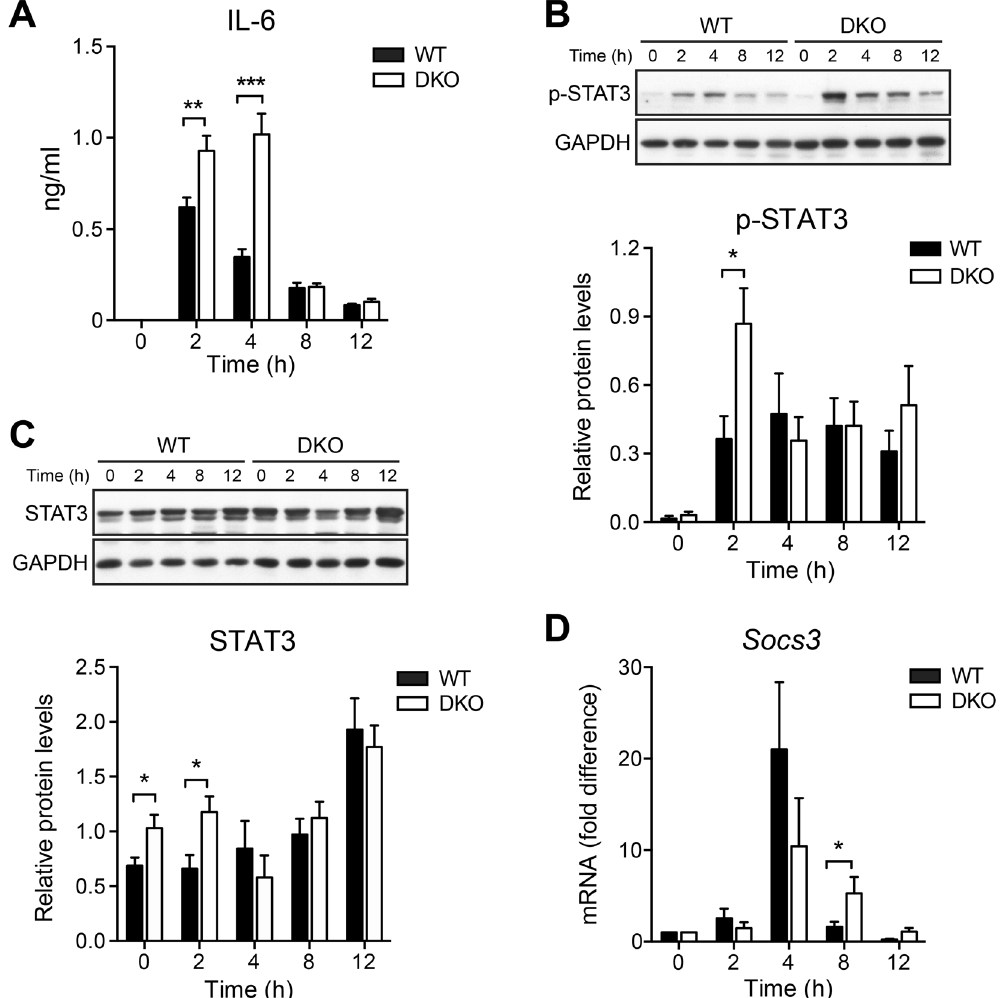
Figure 2. The IL-6 pathway and early STAT3 signalling are enhanced in the absence of cytosolic nucleic acid sensing. (A) Systemic levels of IL-6 were measured using serum samples from 4 to 7 independent mice for each time point and group. (B) Hepatic levels of phosphorylated STAT3 were determined by Western blotting. Representative gels (upper panel) and densitometric analyses (lower panel) are depicted. For each time point and in each group, samples from 6 independent mice were analysed. Cropped gels are shown. Full length gels are available in the supplemental information. (C) Expression of total STAT3 protein was determined by Western blotting. Representative gels (upper panel) and densitometric analyses (lower panel) are depicted. For each time point and in each group, samples from 6 independent mice were analysed. Cropped gels are shown. Full length gels are available in the supplemental information. (D) Expression of SOCS3 mRNA in livers following partial hepatectomy is depicted as fold difference relative to untreated livers. For each time point and in each group samples from 6 to 7 independent mice were analysed. * P < 0.05, ** P < 0.01 *** P < 0.001 (two- tailed unpaired Student’s t-test or the Mann-Whitney U